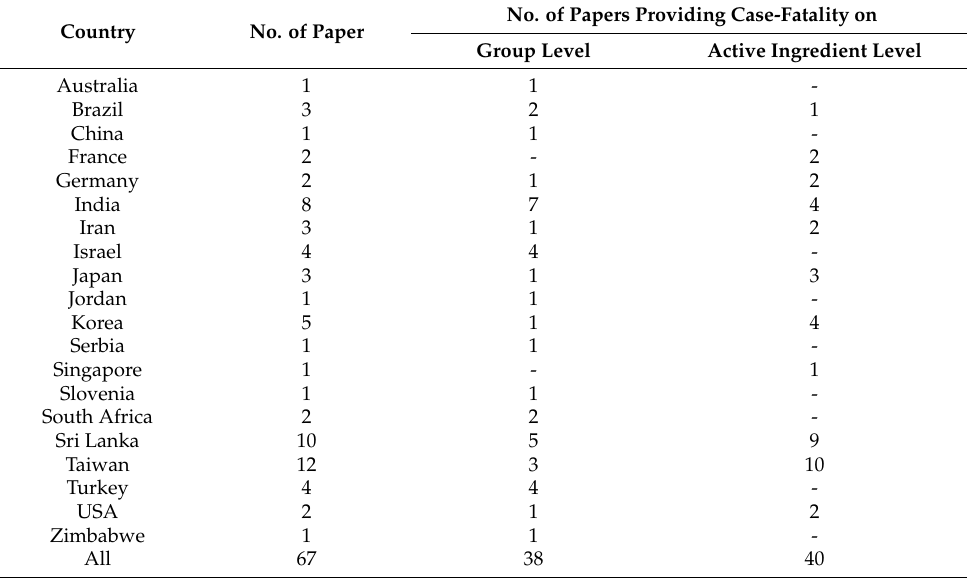
Table 2. Countries addressed and number of papers providing case-fatality of pesticide